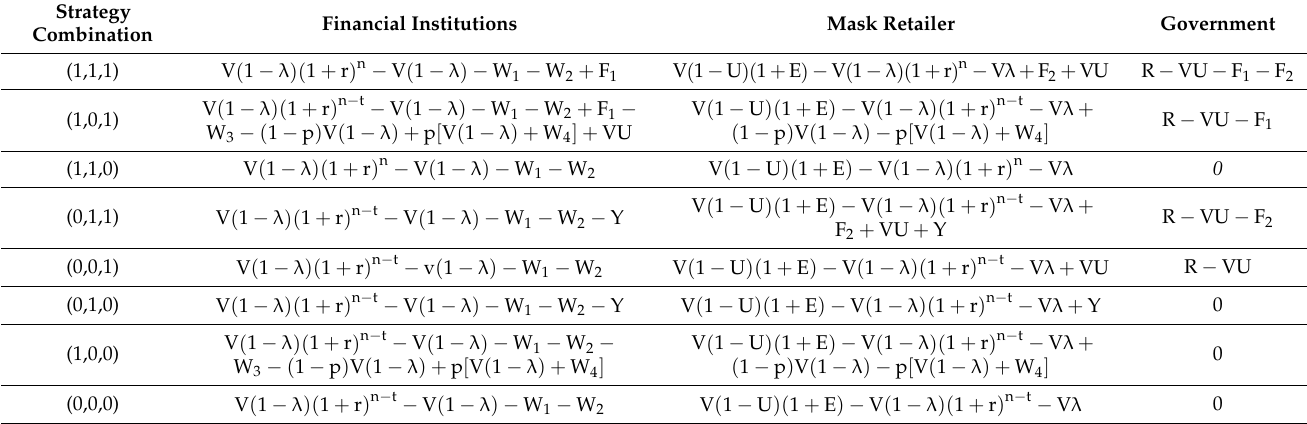
Table 2. Revenue Matrix of Tripartite Game